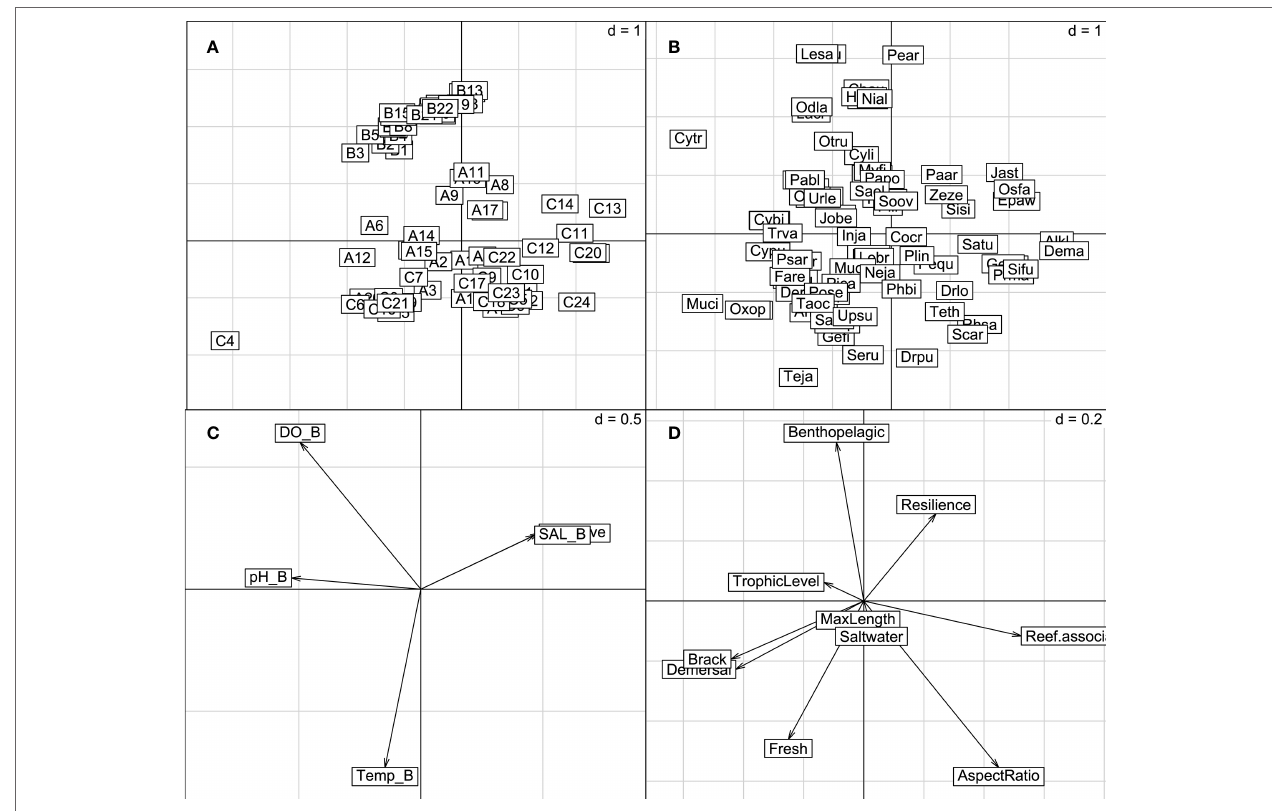
FIGURE 2 | Results of the RLQ analysis on the demersal fish community in the PRE: (A) the site (L) scores, (B) the species (Q) scores, (C) the environmental variables and (D) the species traits. Ai, Bi and Ci in (A) are the sampling sites in August 2020, December 2020 and July 2021, respectively ( Table S1, S2 and S3 ). The acronyms with four letters in (B) are the species in the PRE ( Table S4 ). The variates in (C) are the environmental variables, where DO_B is the DO in the bottom water, pH_D is the pH in the bottom water, Temp_D is the temperature in the bottom water and Depth_Ave is the average depth of the sampling site. The acronyms in (D) are the functional traits of species ( Table S6